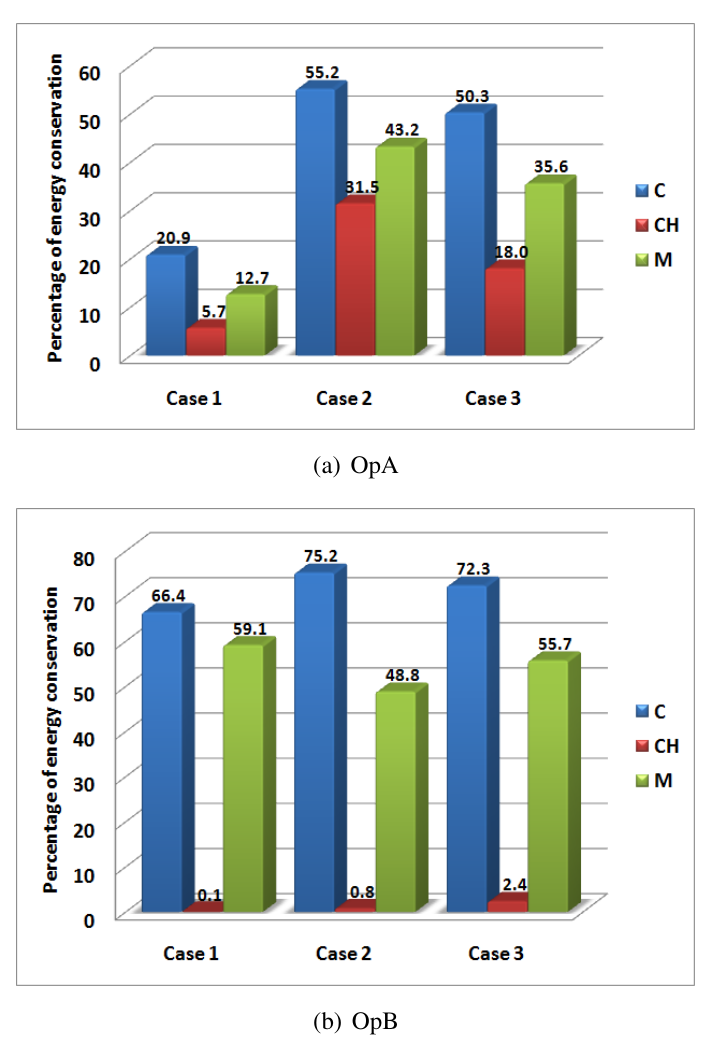
Figure 5. Percentage of energy conservation using the framework, for (a) OpA and (b) OpB, in cases UC-UE, NUC-UE and UC-NUE, comparisons C, CH and M, for a node density of 0 : 3 nodes per m 2